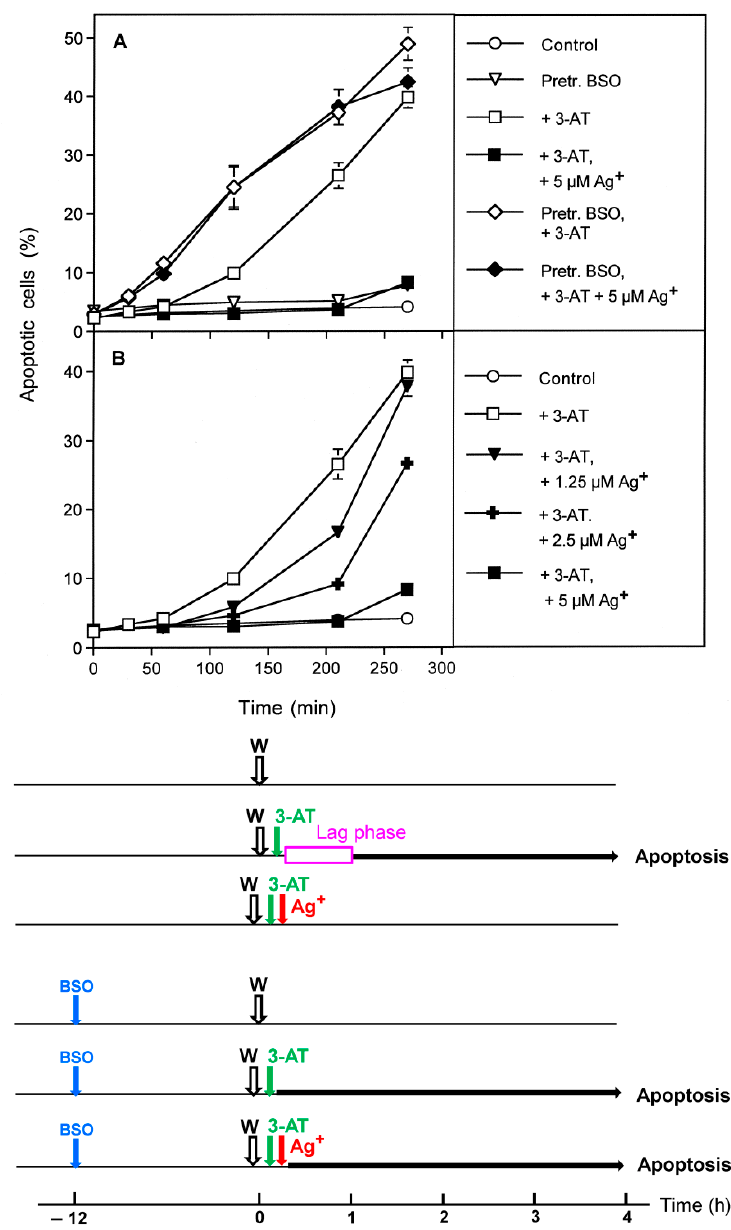
Figure 7. Kinetic analysis of the effects of glutathione depletion and aquaporin action. MKN-45 cells were pretreated for 14 h at 37 ◦ C either in the absence of BSO (control) or in the presence of 10 µ M BSO. Preincubation was followed by three washing steps and seeding of the cells into 96 well plates (12,500 cells/assay). ( A ): Control cells and BSO-pretreated cells received either no further addition, or 100 mM 3-AT (3-AT) or 100 mM 3-AT plus 5 µ M Ag + . The kinetics of apoptosis induction were determined. The results confirmed that BSO-pretreatment by itself was not sufficient for apoptosis induction. Apoptosis induction in control cells required a lag phase of about one hour and was completely dependent on aquaporins, as seen by the strong inhibition by Ag + . In contrast, BSO-pretreated cells did not require a lag phase for apoptosis induction and were independent of the action of aquaporins. These data confirm that the lag phase is due to the action of aquaporins and that glutathione depletion by BSO pretreatment substitutes for the aquaporin effect. ( B ): Control cells remained, without further addition, or received 100 mM 3-AT in the absence of presence of increasing concentrations of Ag + . Apoptosis induction was determined kinetically and illustrates the dependency of inhibition of the aquaporin-mediated effect on the concentration of Ag +